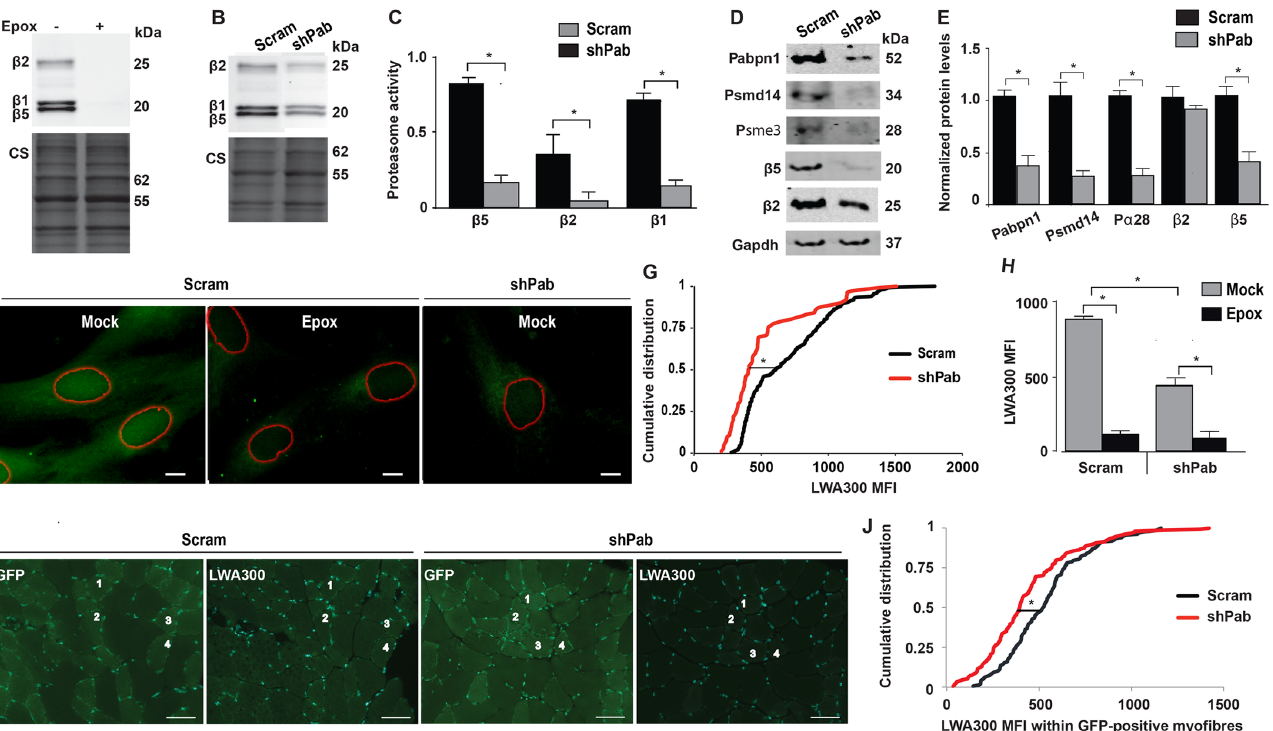
Fig 3. Proteasome activity in Pabpn1-DR cell culture and muscle tissue. A-C. Analyses of β -subunits catalytic activity in muscle cell culture using activity gel. Specific binding of LWA300 to β -subunits is demonstrated by pre-incubation with 0.5 μ M Epox for 1 hour (A). Proteasomal activity in Scram vs. shPab muscle cell cultures (B-C), activity gel shows a representative experiment (B) Equal loading was assessed by Coomassie staining (CS). Bar chart (C) shows LWA300 MFI in after normalization to CS. Averages are from triplicates. D. A representative western blot shows protein levels of proteasome-encoded genes in Scram and shPab cell cultures. E. Bar chart shows quantification of protein fold change after normalization to Scram cultures. Averages and standard variations are from three independent experiments. Statistical significance (p < 0.05; * ) was made with unpaired Student ’ s t-test. F. Images show subcellular localization of LWA300 in Scram or shPab cell cultures. Cultures were incubated with 62.5 nM LWA300, pre-incubation with 0.5 μ M Epox was carried out as control. Segmented nuclei are depicted with red circles. Scale bar is 5 μ m. G. Plot shows cumulative distribution of nuclear LWA300 MFI in Scram or shPab C2C12 cells. Statistical significance (p < 0.05) was assessed with the Kruskal-Wallis test. H. Bar chart shows flow cytometer analysis of LWA300 MFI in Scram or shPab cell cultures treated with or without Epox. Averages are from three experiments. Representative histogram of flow cytometer output is in S2 Fig. I-J. LWA300 signal in muscle cryosections. I. Images show GFP or LWA300 fluorescence in successive cryosections from Scram or shPab. Examples of the four same myofibers in GFP and LWA300 are depicted with numbers. Nuclei were counterstained with DAPI. Scale bar is 50 μ m. J. Plot shows cumulative distribution of nuclear LWA300 MFI in cryosections from three mice. Over 400 myofibers are included per condition per mouse. Statistical significance (p < 0.05) was assessed with Kruskal-Wallis